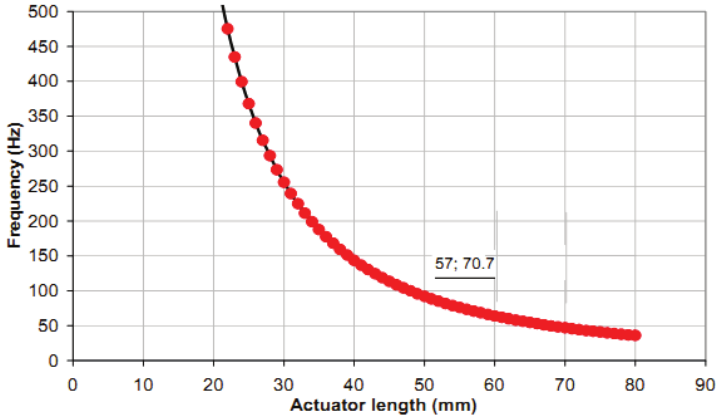
Figure 13. Relationship between frequency and actuator